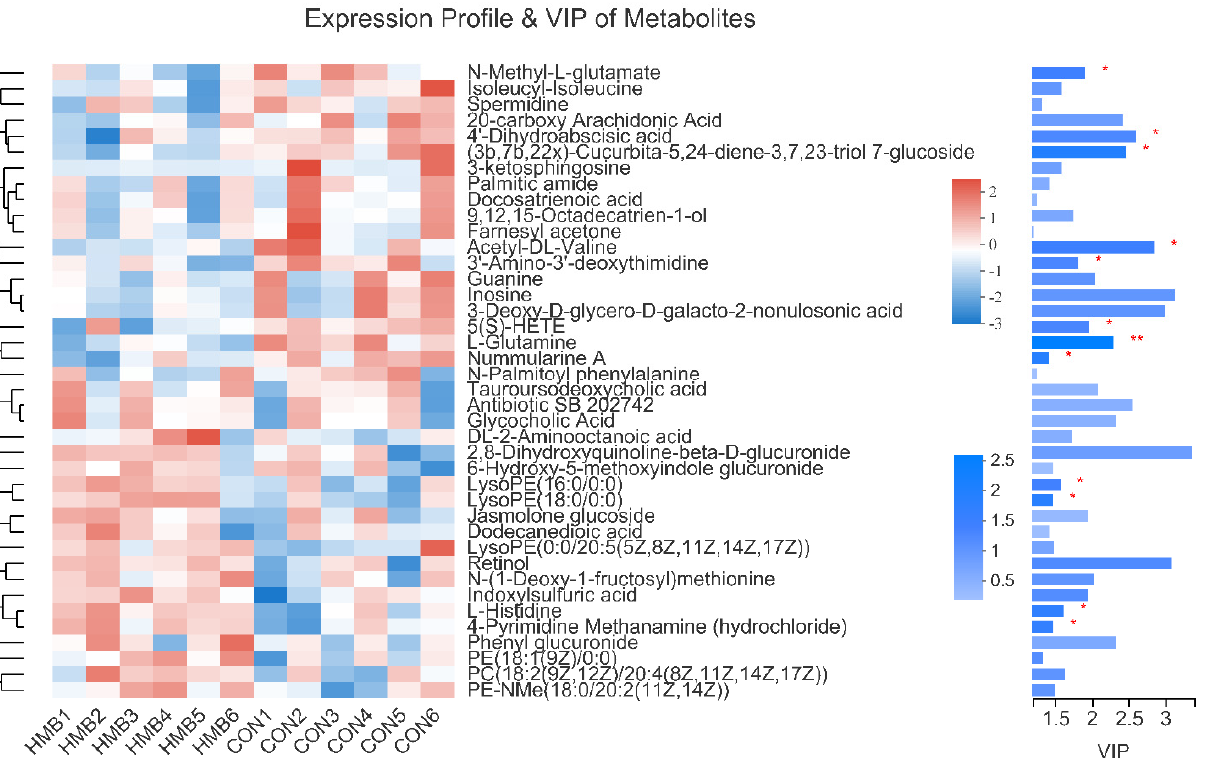
Figure 3. Expression profile and variable importance in the projection (VIP) values of serum metabolites in the control and HMB1 (0.13%) diets. On the left side is the dendrogram of metabolites clustering, the closer the branches are, the closer the expression patterns of all metabolites in the sample are; each column represents a sample, and the bottom is the sample name; each row represents a metabolite, and the color represents the relative expression amount of the metabolite in the group of samples, and the corresponding relationship between the color gradient and the numerical value is shown in the gradient color block. On the right side is the VIP bar graph of metabolites (VIP > 1). The length of the bar represents the contribution value of the metabolite to the difference between the two groups, which is not less than 1 by default. The larger the value, the greater the difference between the two groups. The bar color indicates the significant difference of metabolites between the two groups. Levels of significance are defined as * p < 0.05 and ** p < 0.01.